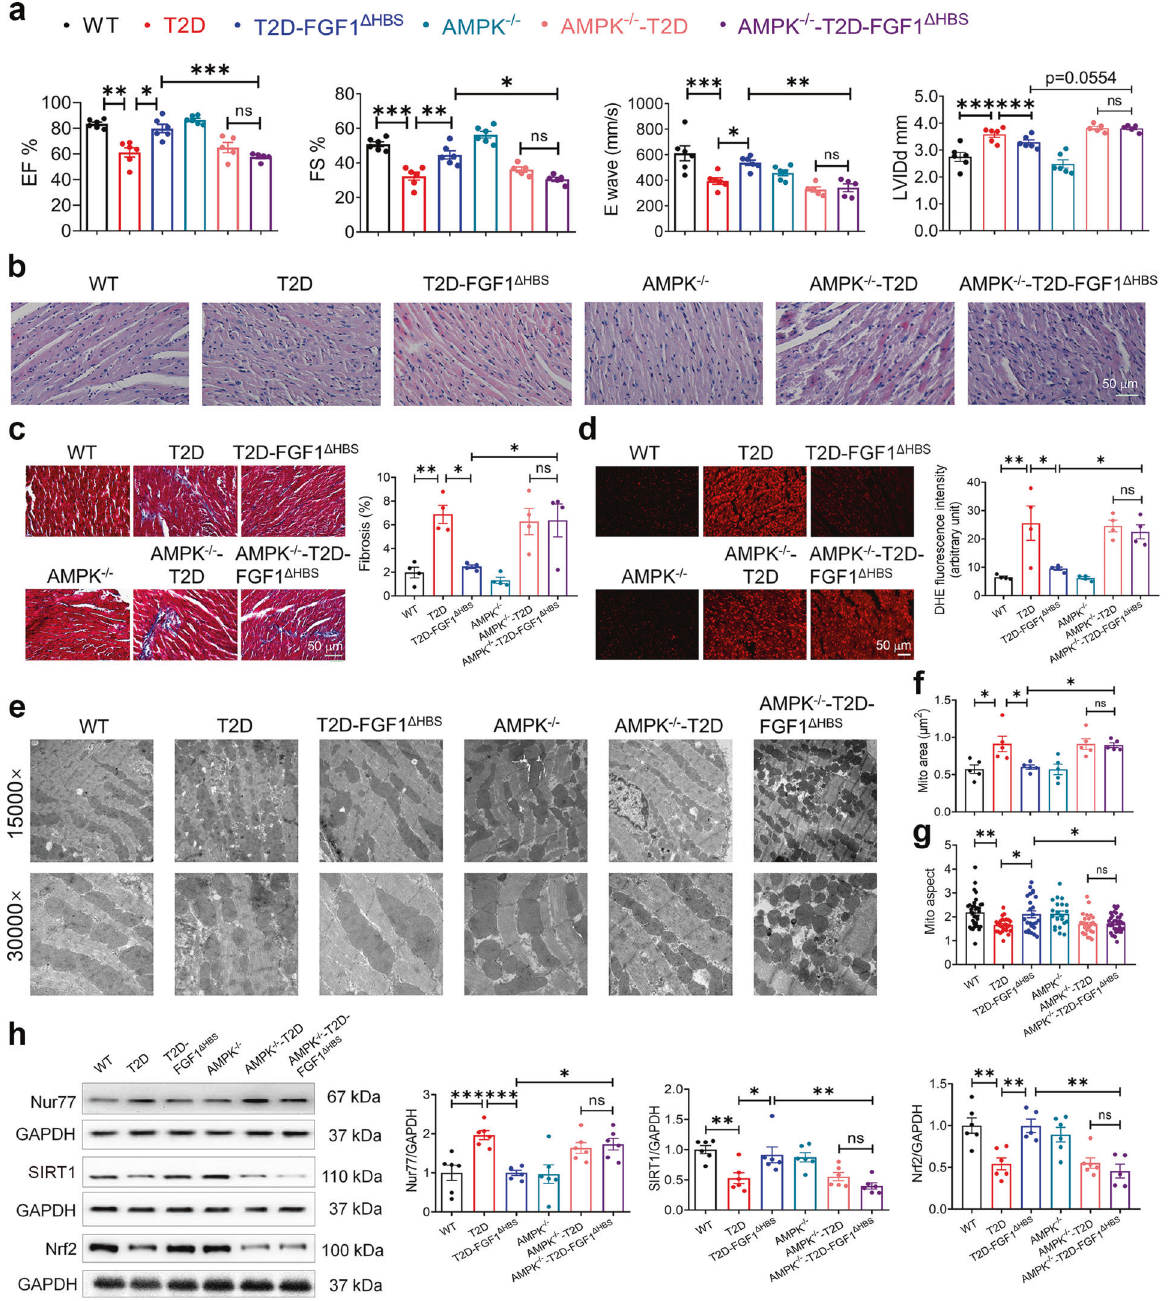
Fig. 7 AMPK mediates the protective effect of FGF1 Δ HBS against DCM in vivo. a – h At the age of 8 weeks, male wild type (WT) or AMPK α 2 knockout mice were fed with a high-fat diet for 8 weeks and intraperitoneal injected with STZ, and then treated with FGF1 Δ HBS (0.5 mg/kg body weight) or saline every other day for 8 weeks. a Echocardiographic assessment for each group. n = 5 – 6. b H&E staining of the cardiac tissues. c Masson ’ s trichrome staining (left panel) and quantitative analysis (right panel) of cardiac fi brosis area. n = 4. d Representative images (left panel) and quanti fi cation (right panel) of fl uorescence intensity of DHE in cardiac tissues. n = 4. e Representative transmission electron micrographs of the cardiac tissues. f Mitochondrial area of the cardiac tissues. n = 5. g Mitochondrial aspect ratio (long/short axis) of the cardiac tissues. n = 21 – 37. h Western blot analysis (left panel) and densitometric quanti fi cation (right panel) of Nur77, SIRT1 and Nrf2 in the cardiac tissues. n = 5 – 6. Data were mean ± SEM; * P < 0.05, ** P < 0.01, *** P < 0.001; ns, not signi fi